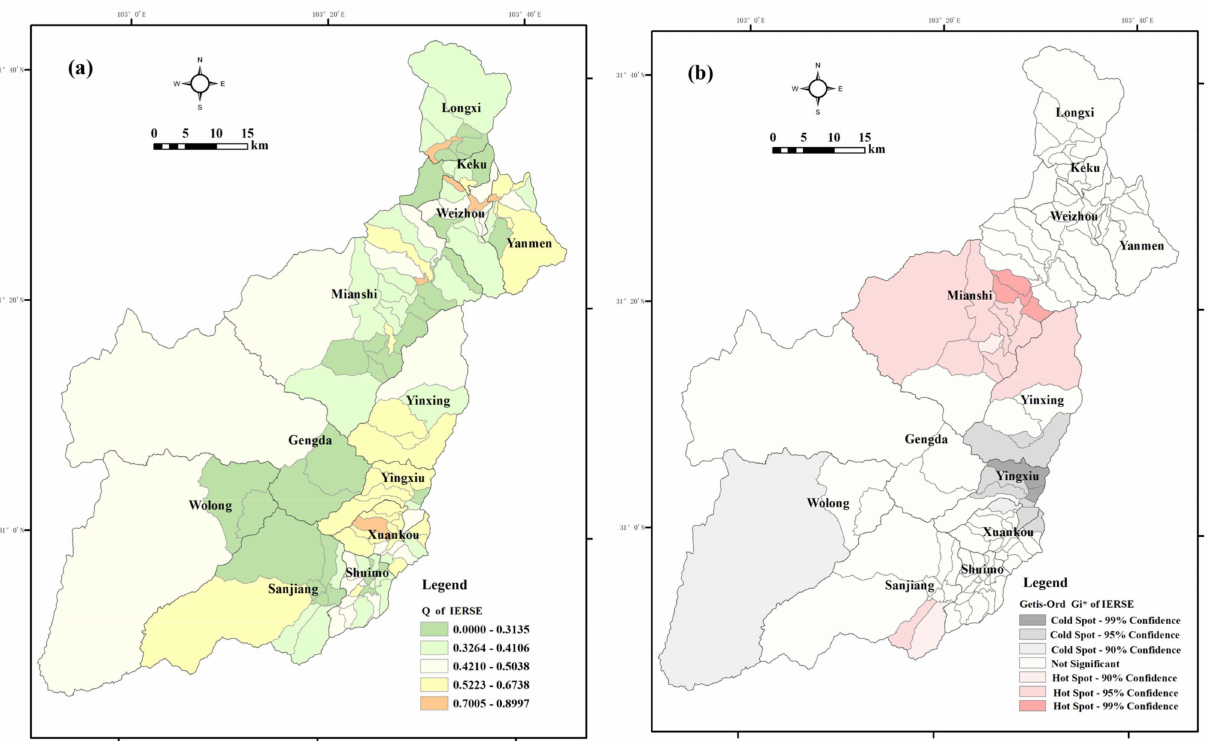
Figure 3. The spatial distribution of IERSE in Wenchuan County; ( a ) Q of IERSE; ( b ) Getis-Ord Gi* of